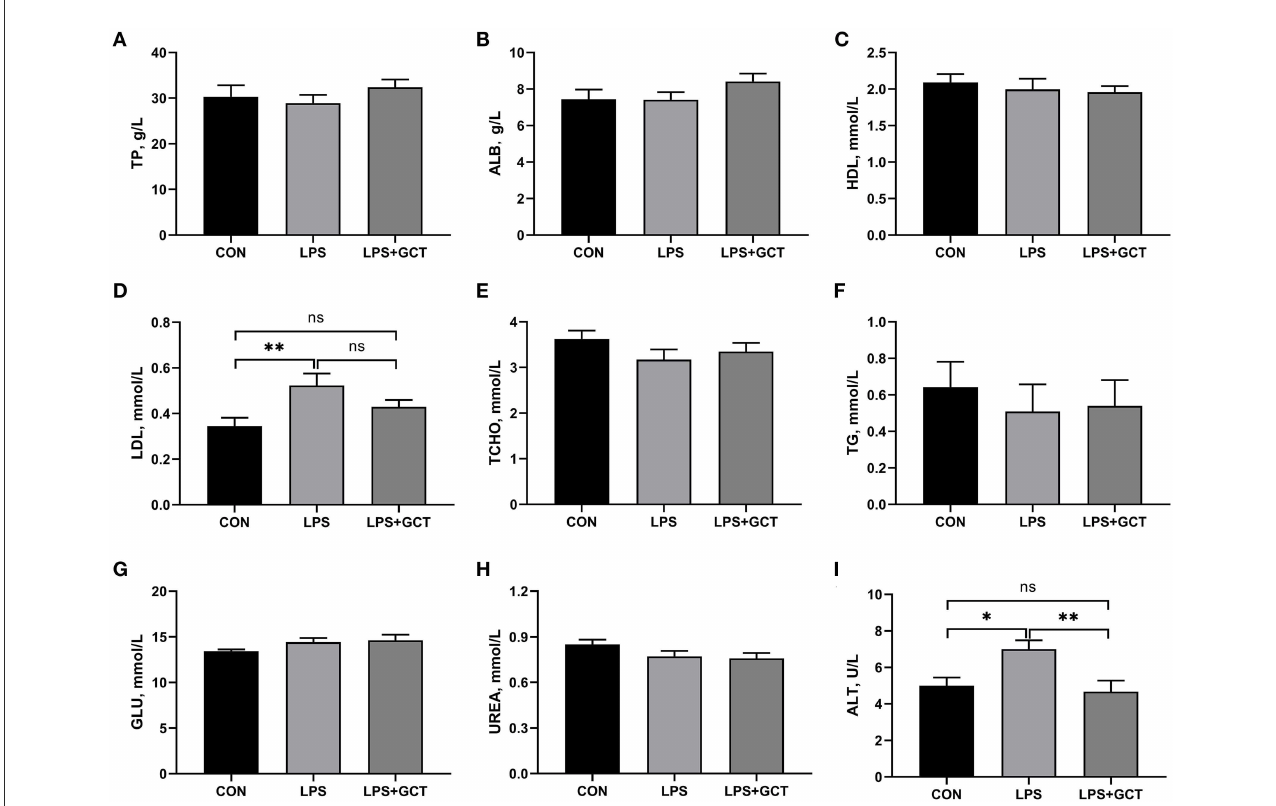
FIGURE1 Effects of dietary Galla Chinensis tannin (GCT) supplementation on serum biochemical parameters of broilers under lipopolysaccharide (LPS) challenge. (A) Total protein (TP); (B) Albumin (ALB); (C) High-density lipoprotein (HDL); (D) Low-density lipoprotein (LDL); (E) Total-cholesterol (TCHO); (F) Triglyceride (TG); (G) Glucose (GLU); (H) Urea nitrogen (UREA); (I) Alanine transaminase (ALT). CON, fed on a basal diet and intraperitoneally injected with saline solution; LPS, fed on a basal diet and intraperitoneally injected with LPS; LPS + GCT, fed on a basal diet supplemented with 300 mg/kg GCT and intraperitoneally injected with LPS. Values are presented as mean ± standard error ( n = 6). * p < 0.05, ** p < 0.01; ns, non-significant.